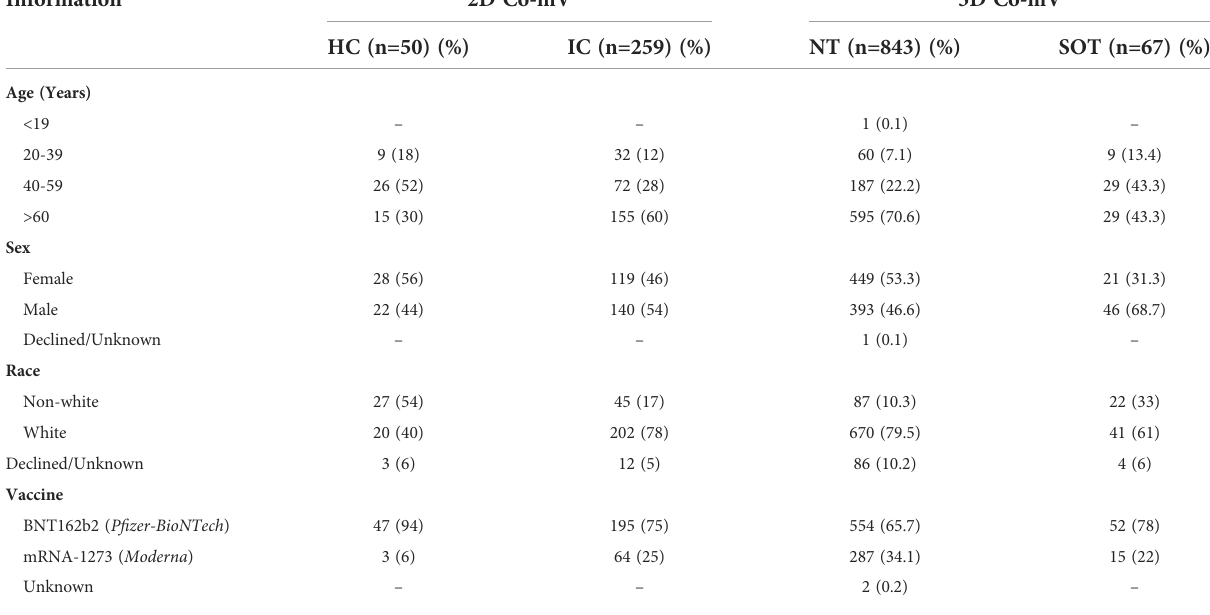
TABLE 1 Demographic and clinical characteristics of study